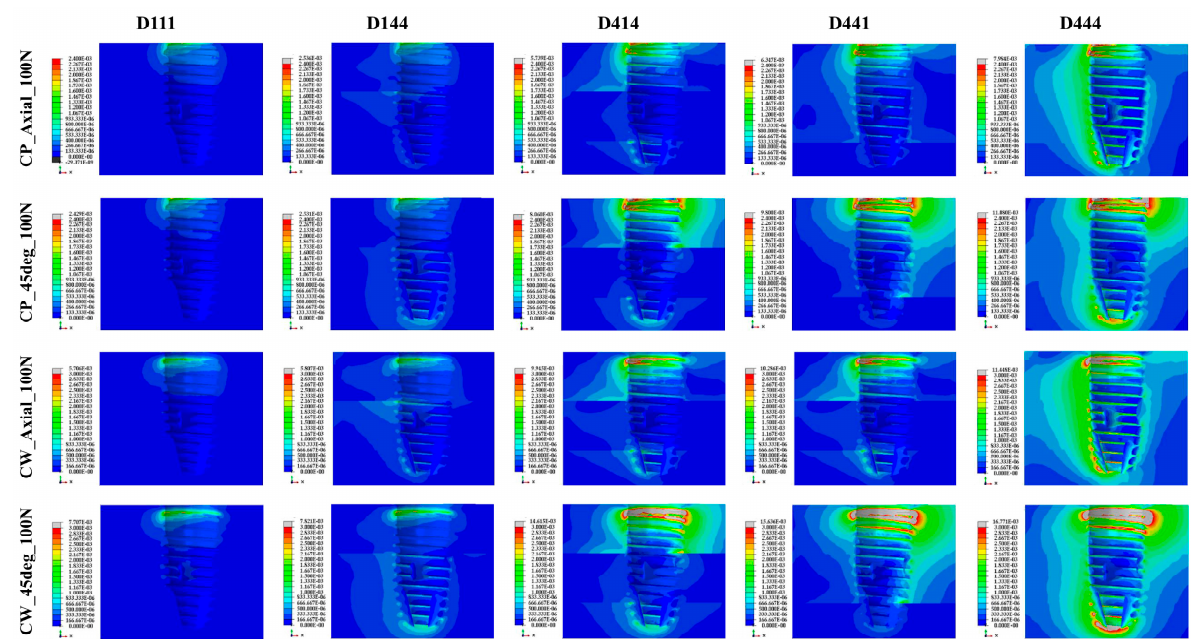
Figure 6. Cross-sectional view of the maximal principal strain values for the 5 bone densities and 2 surgical techniques under 100 N axial load and 30 N oblique load.